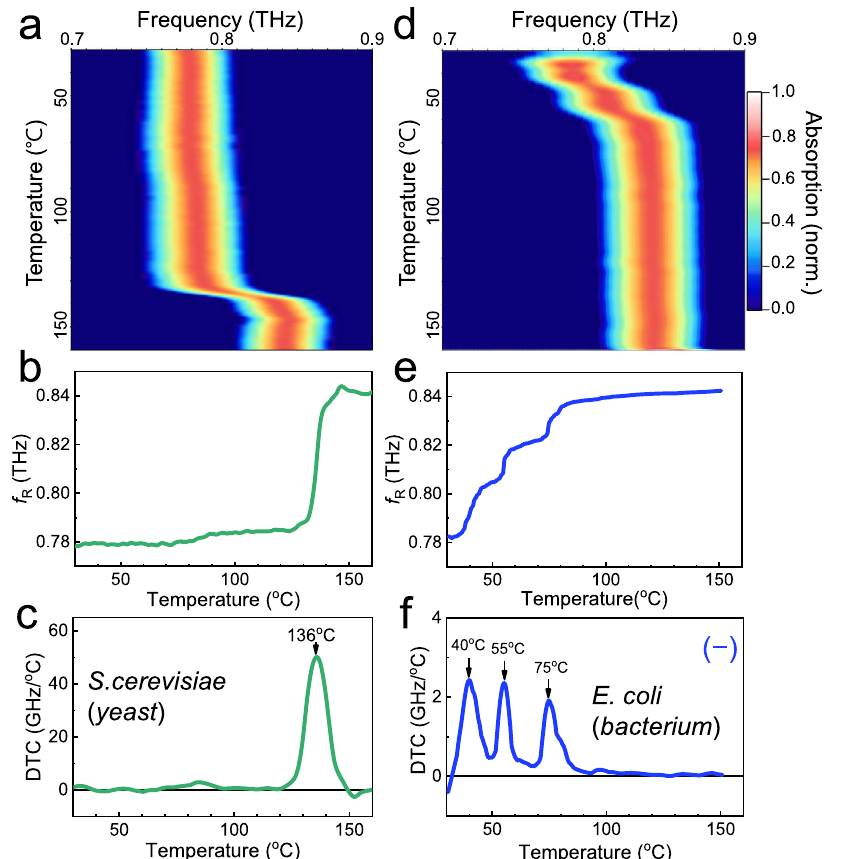
Fig. 2 Experimental results for thermal curve analysis obtained from in situ THz spectroscopy. a 2D plot of THz absorption through metamaterials coated with a yeast layer ( S. cerevisiae ) as functions of the spectrum ( x -axis) and temperature ( y -axis). b Metamaterial resonance ( f R ) as a function of temperature extracted from a . c DTC (d f R /d T ) for the yeast layer obtained by differentiating the curve in ( b ). d 2D plot of THz absorption for a metasensor coated with a E. coli layer. e f R – T plot extracted from d . f DTC for the E. coli layer. Minus sign ( – ) in f indicates that E. coli is the Gram-negative